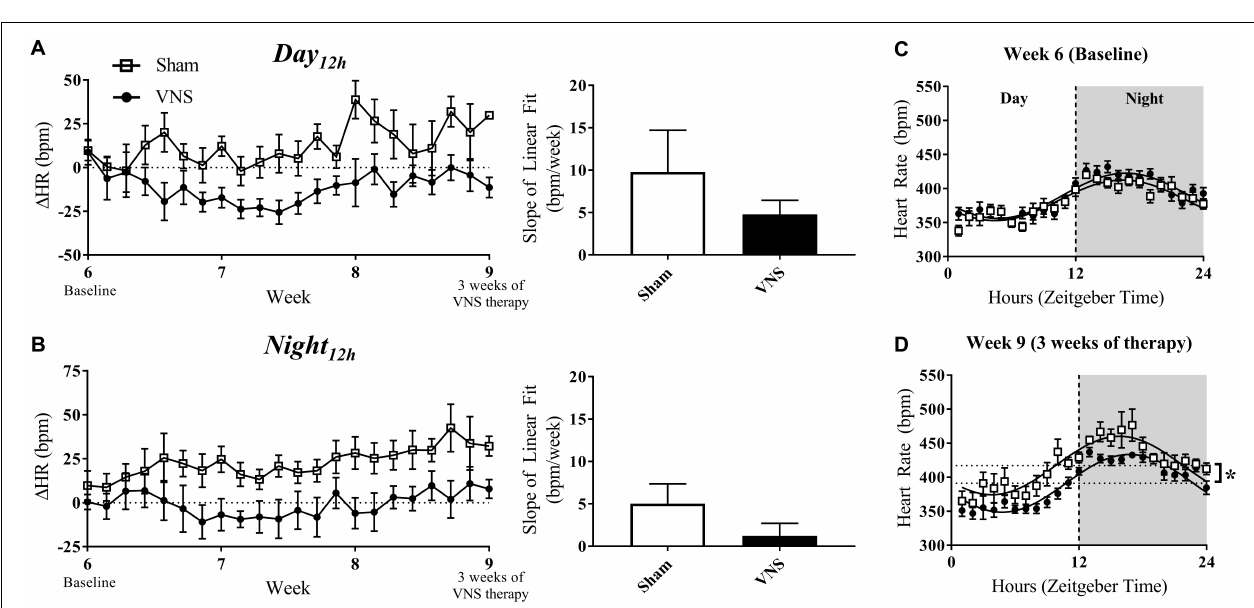
FIGURE 4 | Relative changes in HR ( (cid:49) HR) as HTN progresses. (cid:49) HR as a function of time and slopes of the linear regressions are shown for Sham and VNS rats during the (A) Day 12h interval and (B) Night 12h intervals. Circadian rhythm analysis of HR for Sham and VNS rats are shown for Week 6 (C) and Week 9 (D) . ∗ Indicates statistical significance between Sham and VNS rats.